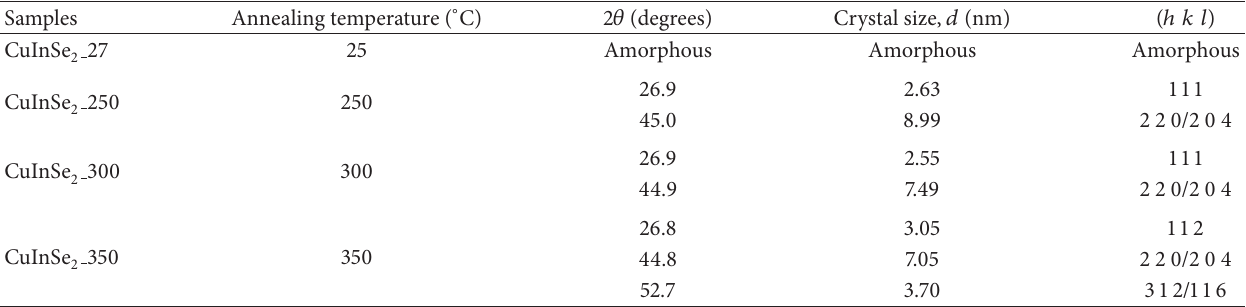
Table 2: Crystal size and diffraction angle for each of annealing temperature.